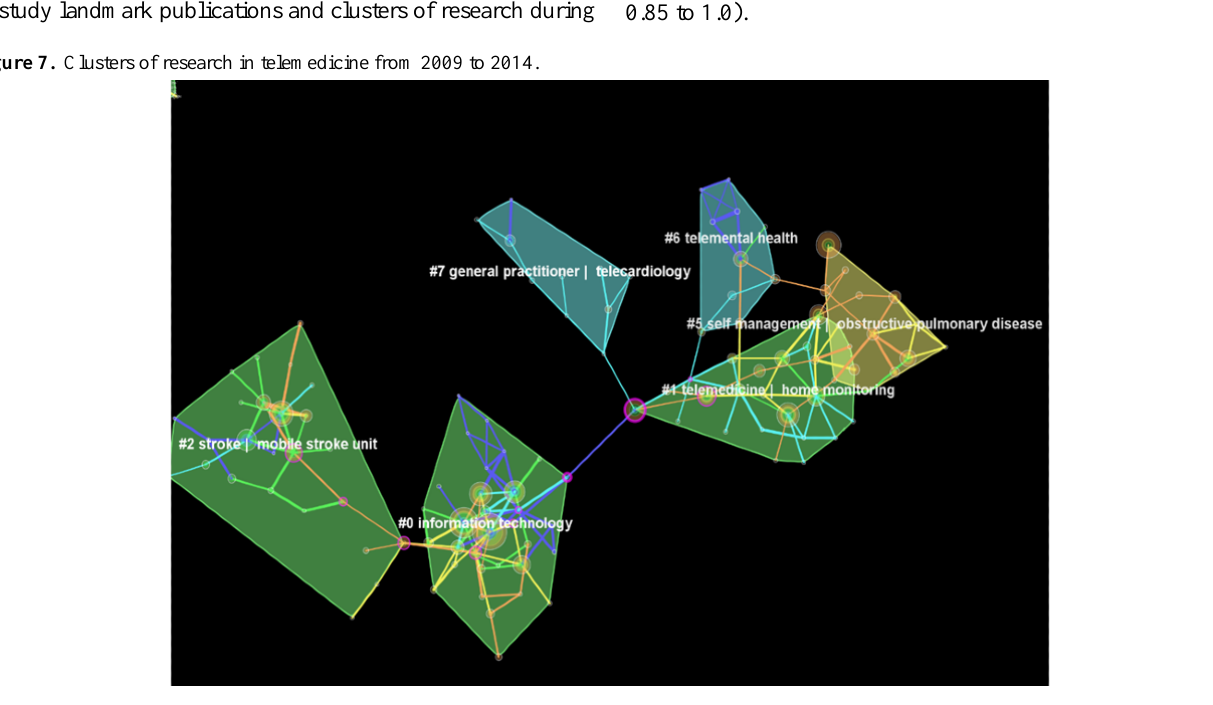
Most frequent keywordsTheme